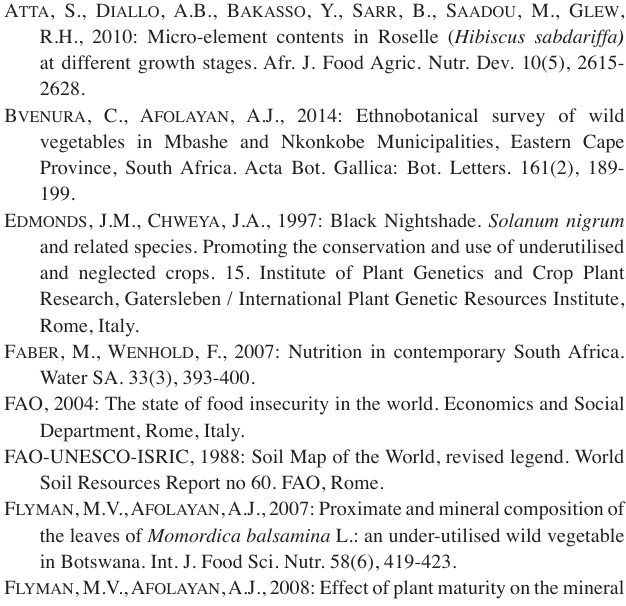
0 indicates readings taken at the time of transplanting Values shown are mean ± S.D. Means with different letters down the same column represent significant differences at p <